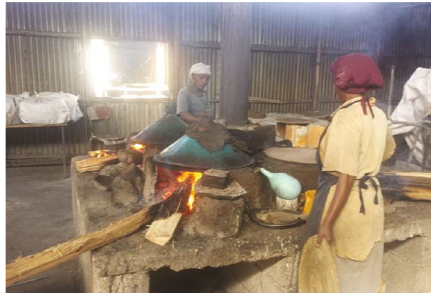
Figure 1: Atse Fasil Campus cafeteria kitchen while baking injera from fi rewood.